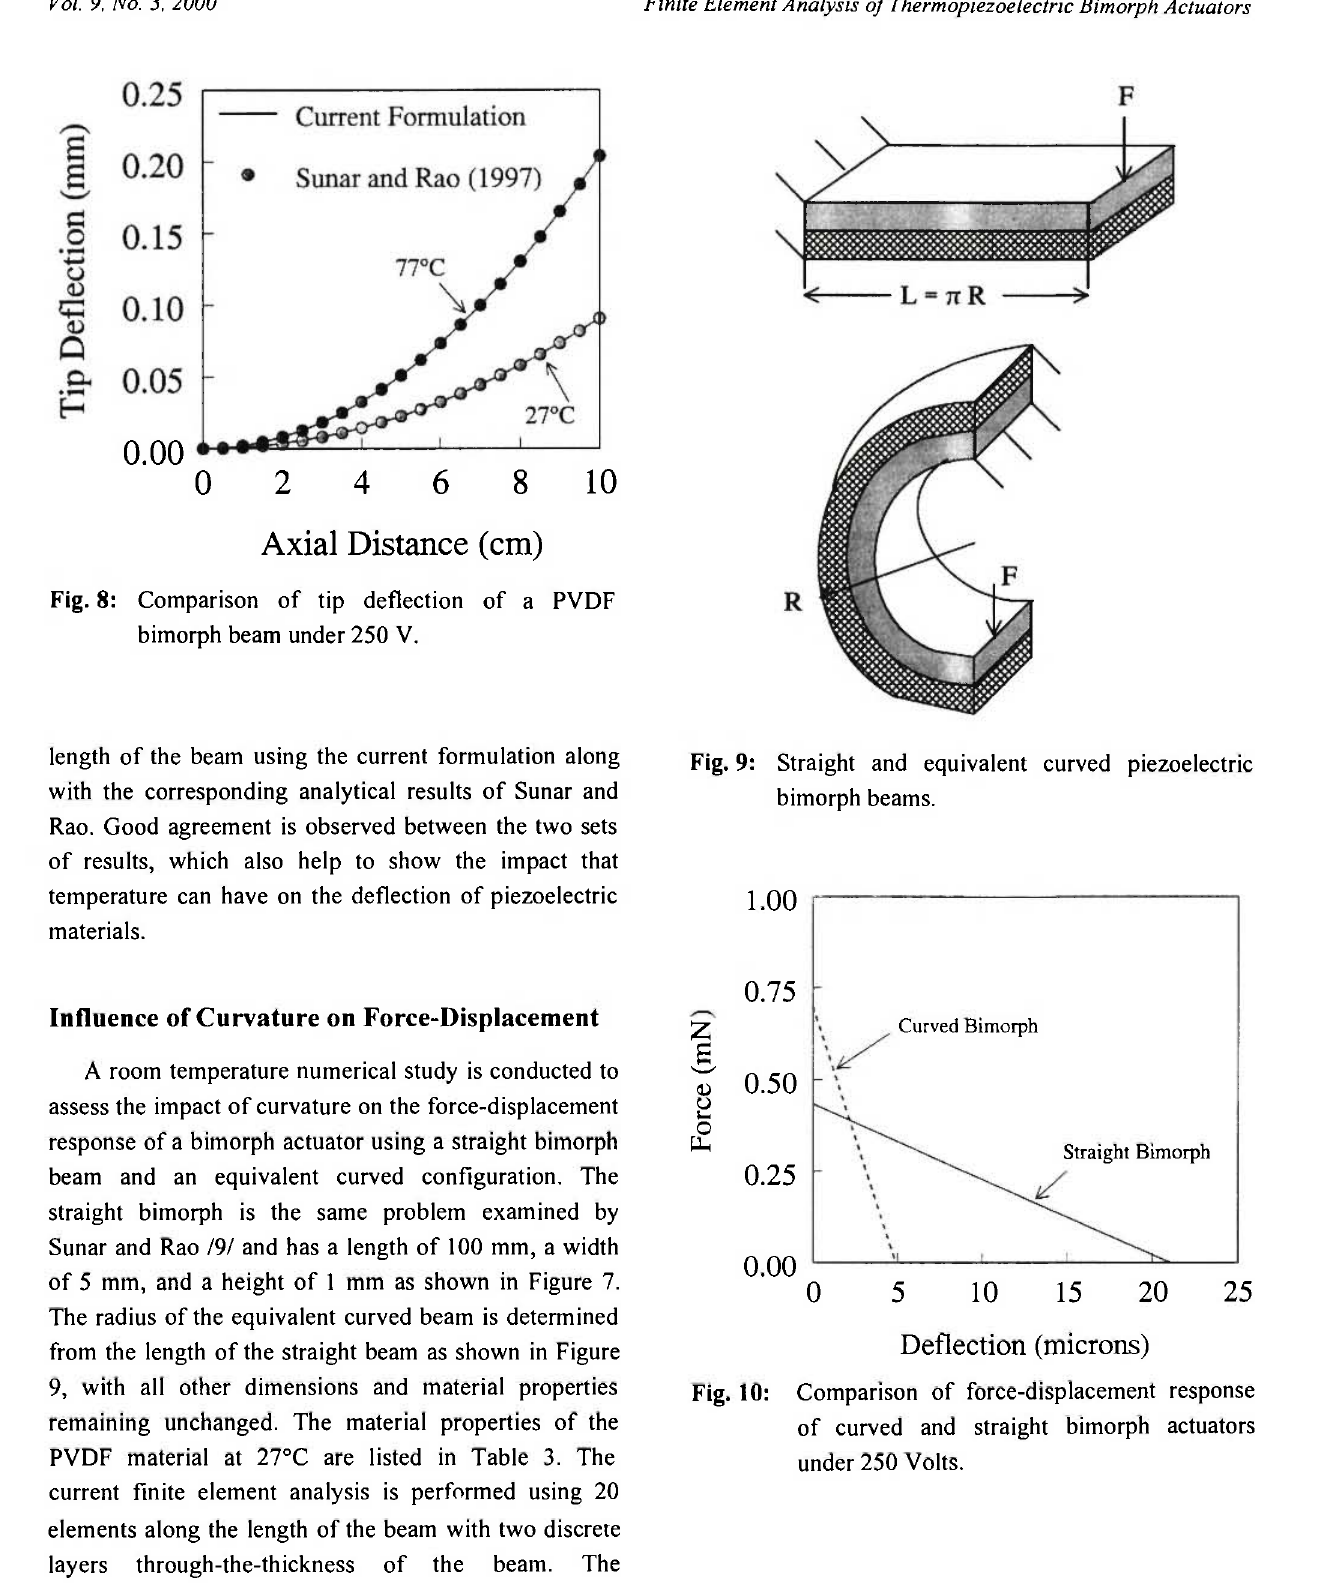
Fig. 10: Comparison of force-displacement response of curved and straight bimorph actuators under 250